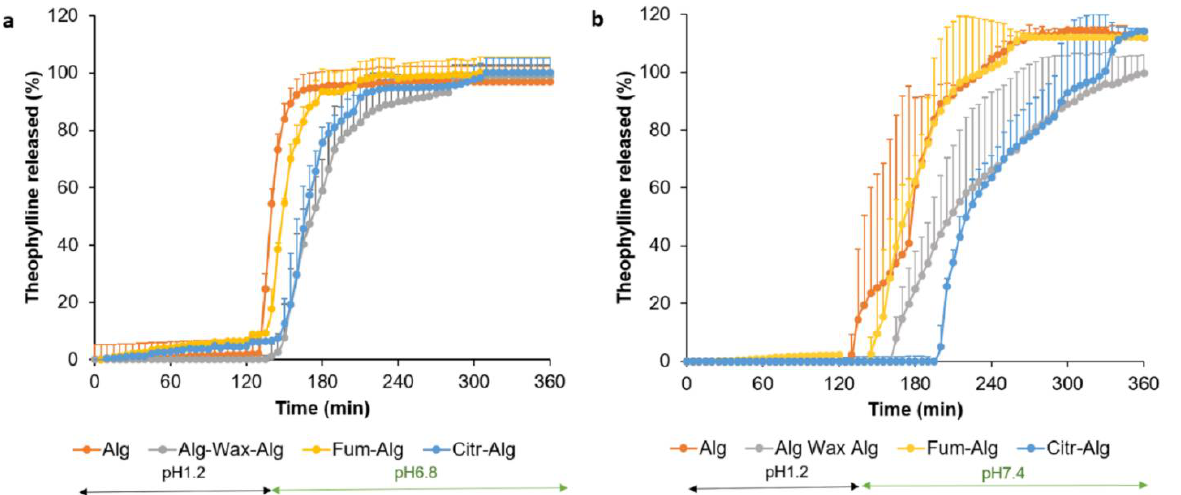
Figure 5. In vitro theophylline release from tablets coated with (Alg (F2), Alg-Wax-Alg (F5), Fum-Alg (F6,) and Citr-Alg (F7)) in acid stage followed by ( a ) intestinal phosphate buffer pH 6.8; ( b ) Krebs’s bicarbonate physiological buffer pH 7.4.